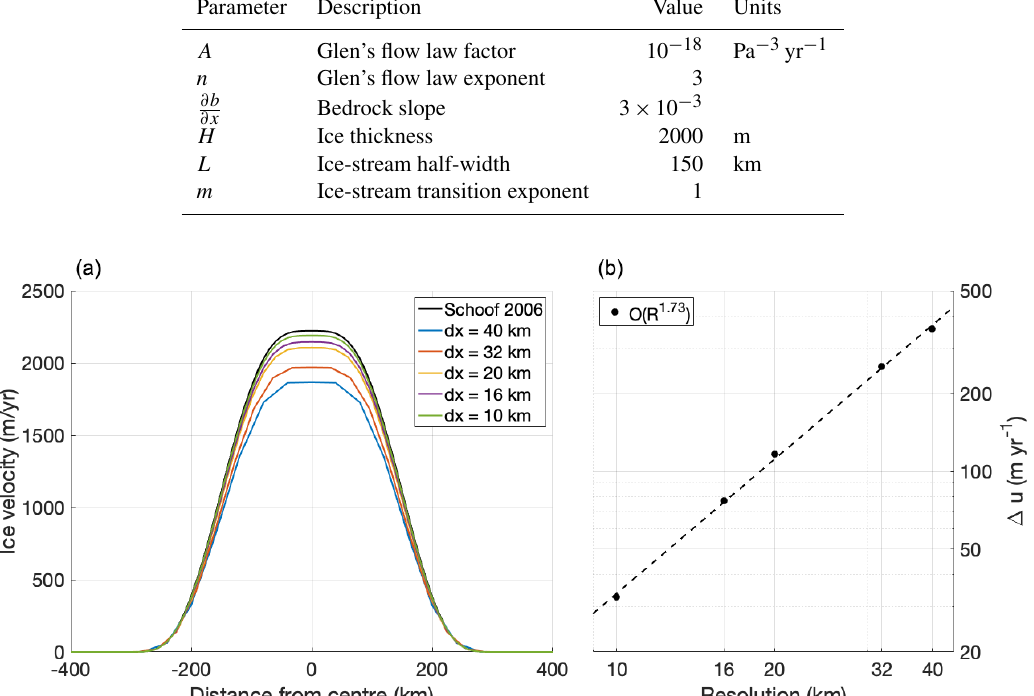
Figure 3. (a) Cross-slope transect of the downslope velocity in the Schoof (2006) ice-stream experiment at different resolutions. (b) Error in the mid-stream velocity versus grid resolution, showing a convergence on the order of 1.73.